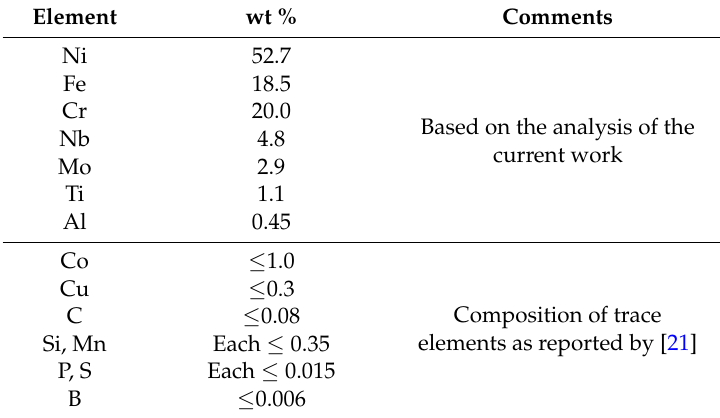
Table 1. The chemical composition of as-received IN718 powder.